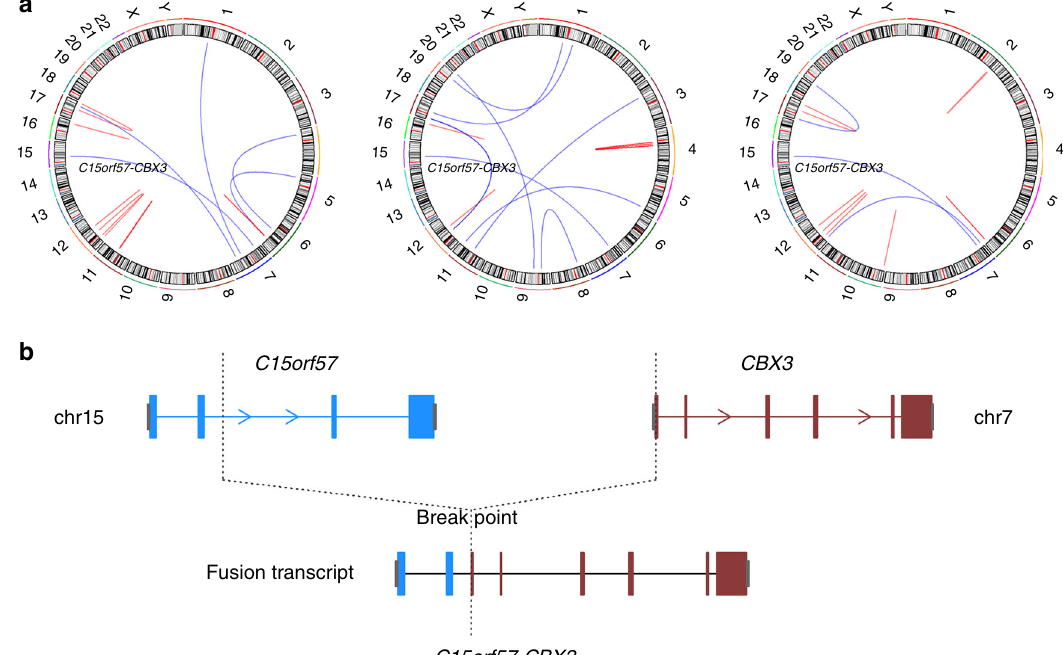
Fig. 5 Circos plot for sample B972, D739, D740, and schematic sample of fusion genes: C15orf57 - CBX3 . a Circos plot for Sample B972, D739, D740. C15orf57 - CBX3 was identi fi ed from RNAseq. b Schematic view of C15orf57-CBX3 fused